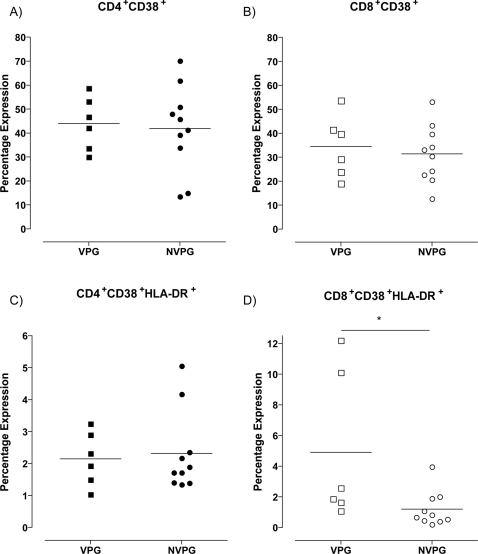
Total T cell activation was not influenced by exposure.The expression level of activation markers CD38 and HLA-DR were compared between VP group (squares, n = 6) and NVP group (circles, n = 10). The expression of CD38 on total CD4+ (A) and total CD8+ (B) T cells showed no significant difference. No significant difference was seen in CD4+ T cell co-expression of CD38 and HLA-DR (C). However, CD8+ T cells from the VP group co-expressed significantly higher of CD38 and HLA-DR compared to the NVP group (denoted by *) (D).